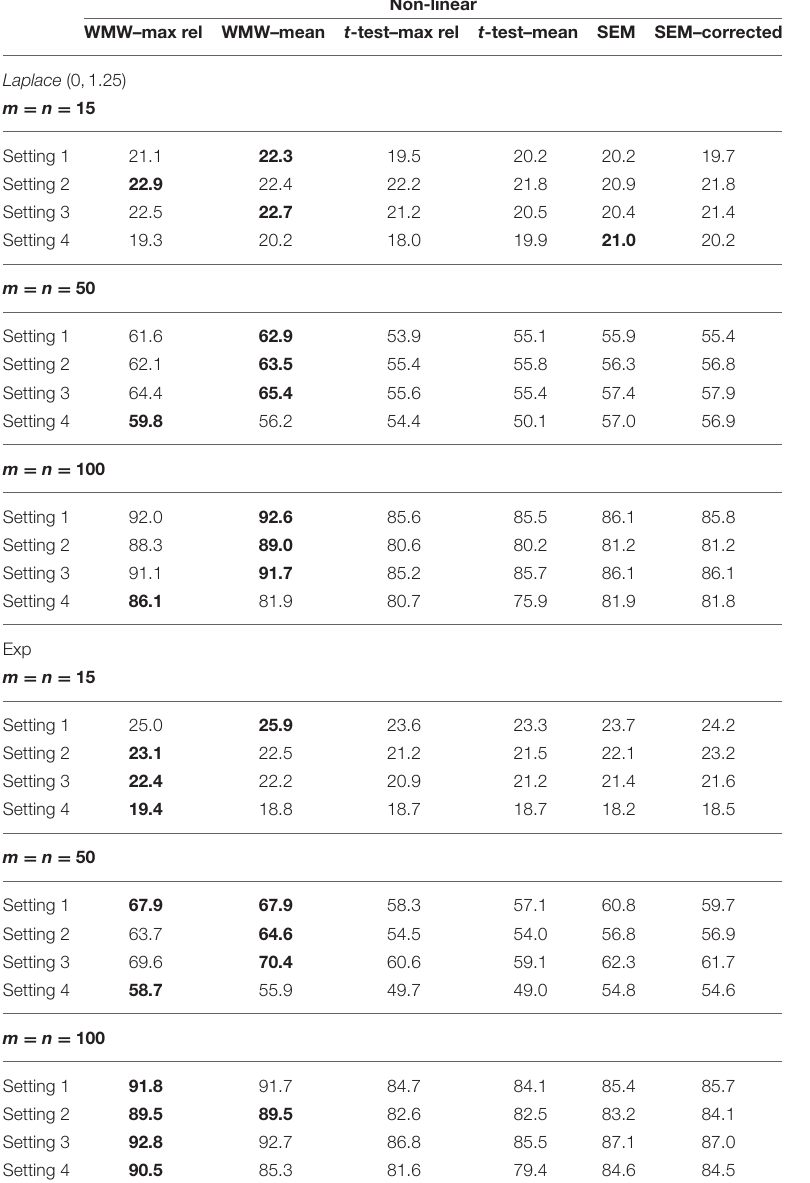
TABLE 3 | Empirical power from the simulation study with the indicators having an overall reliability of 80% and a non-linear relationship with the latent variable. Non-linear